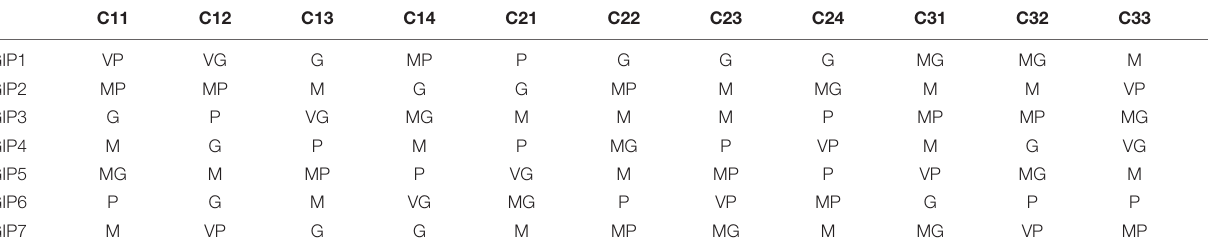
TABLE 3 | The evaluation matrix of academic institutions provided by AHEE experts.